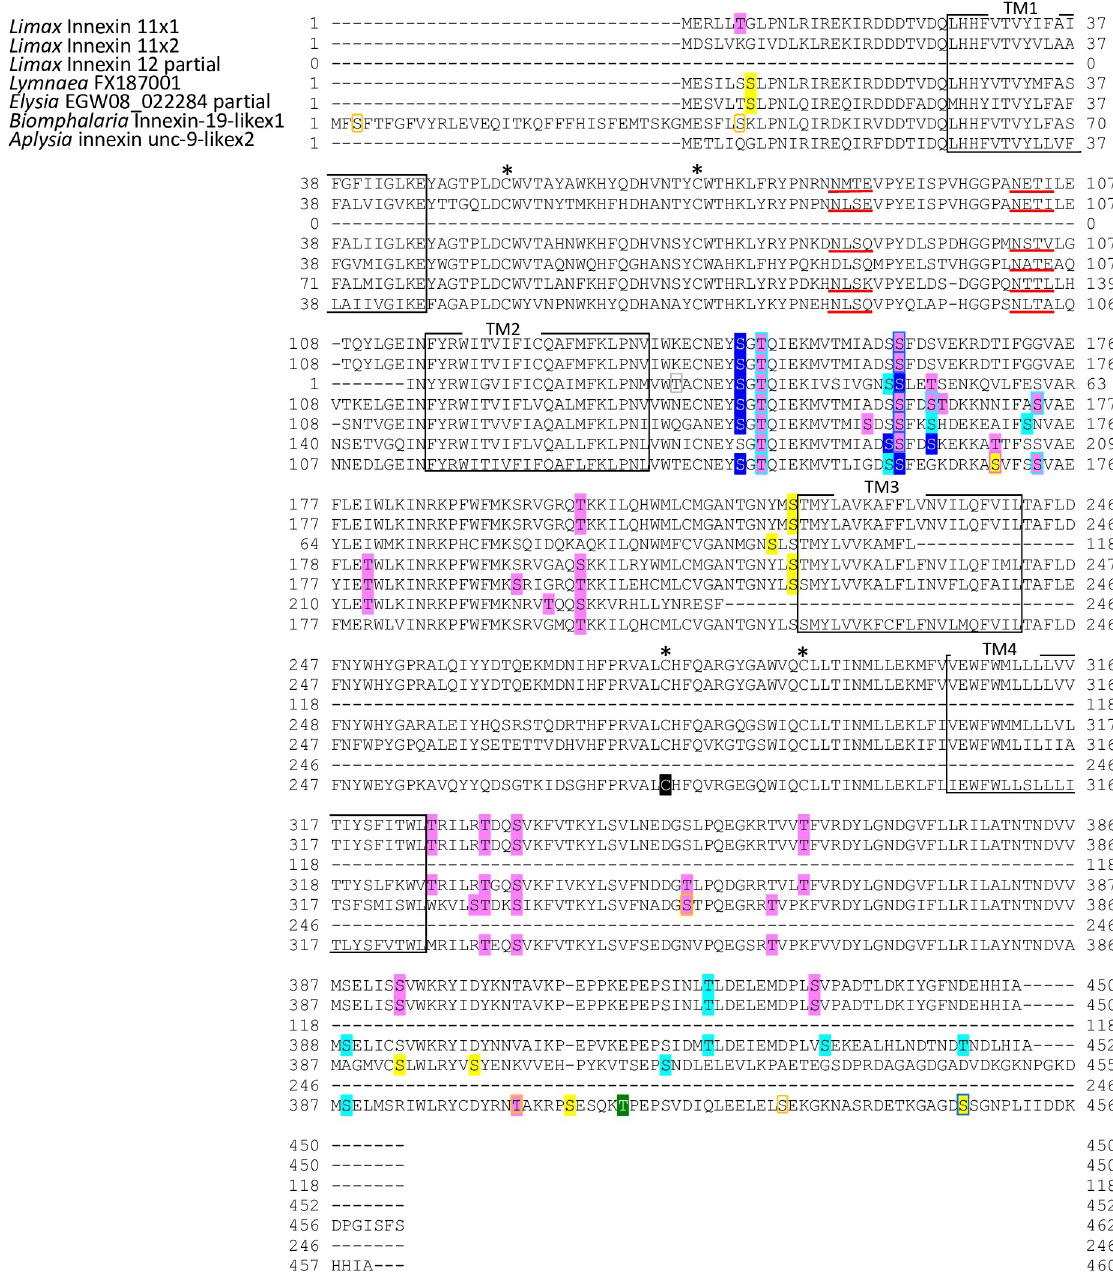
Fig 9. Protein sequence alignment of molluscan innexin orthologs in Group 7. Alignment of deduced amino acid sequences of Limax innexin 11 and 12 with orthologous innexin sequences. The boxes show the four transmembrane domains, while the asterisks indicate the extracellular cysteine residues. The potential S-nitrosylation sites are shaded in black. The phosphorylation sites are indicated with shading or box in magenta (protein kinase C), yellow (protein kinase A), blue (casein kinase 1), cyan (casein kinase 2), orange (P34cdc2), green (p38-mitogen-activated protein kinase), and gray (protein kinase G). Potential N-glycosylation sites are underlined with bold red lines.